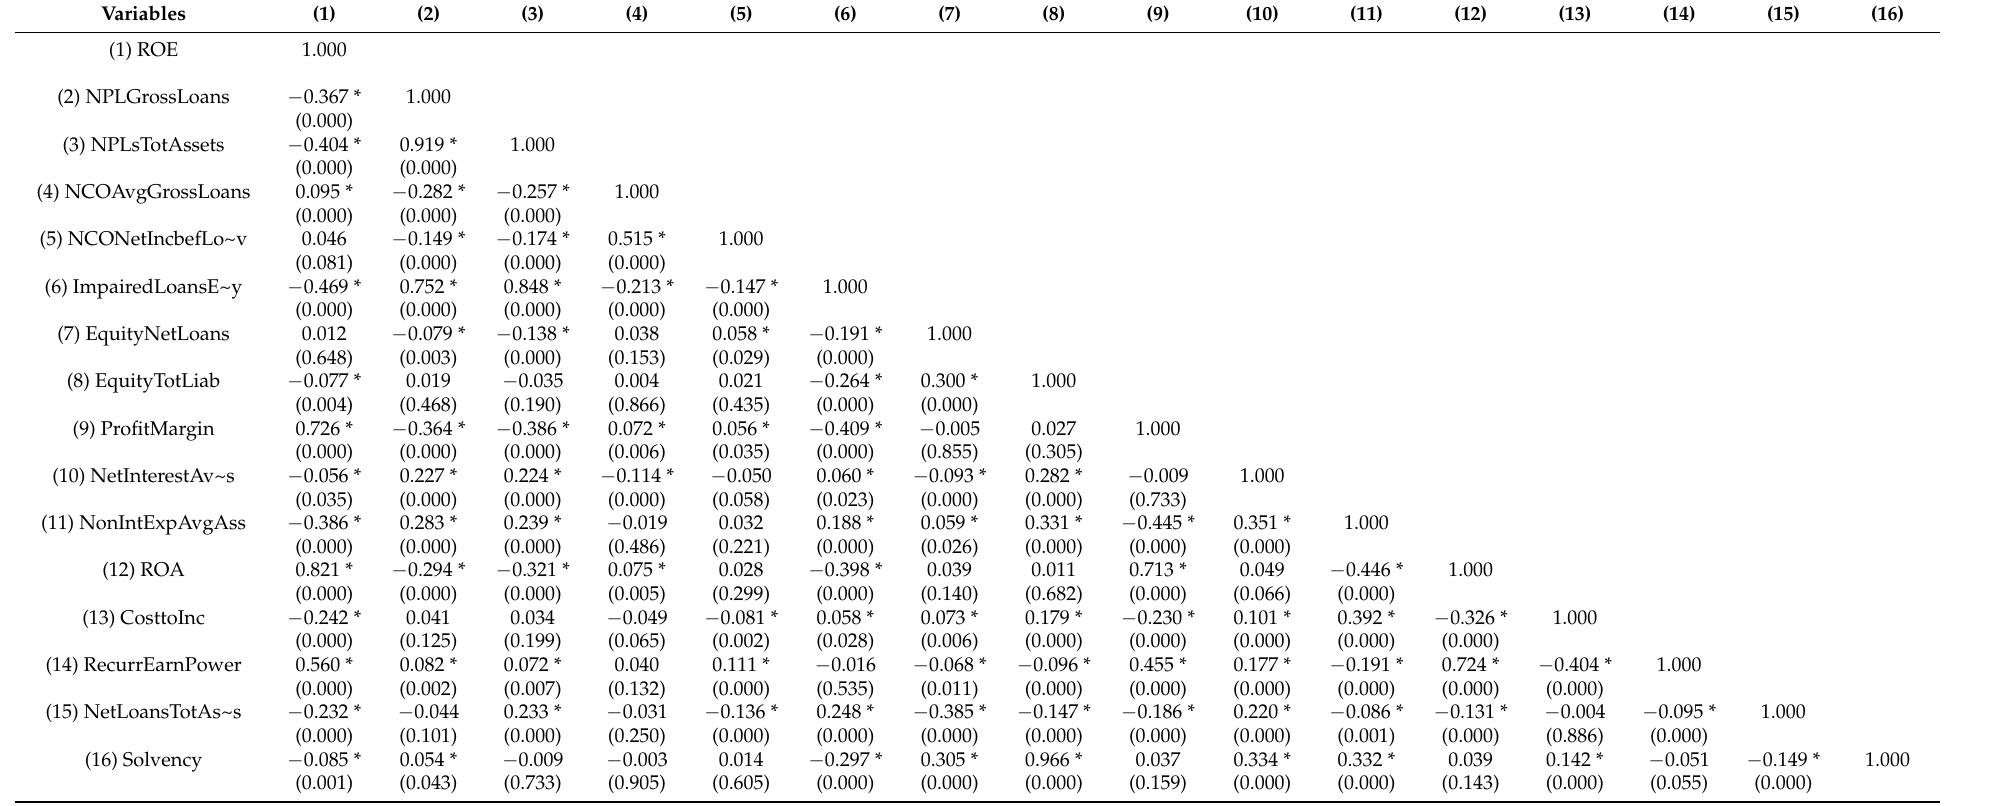
Table 2. Pairwise correlations among key statistics of the 142 Italian banks. Authors’ development on data sourced from ORBIS—Bureau Van Dijck.